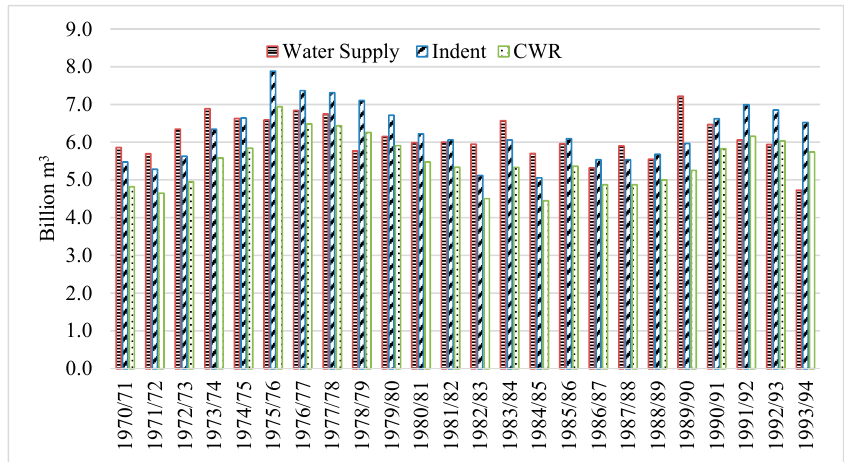
Figure 4. Water supply volume against Indent and CWR at MOIWR period.